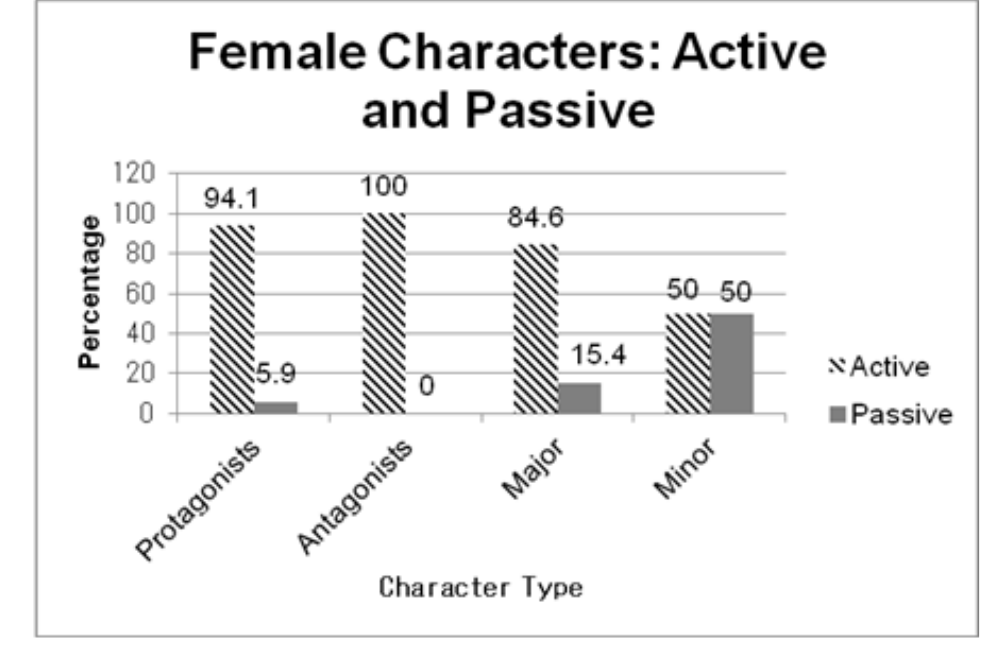
Females divided by overall activeness or passiveness. It is likely that character position and authority has more supremacy in determining a character’s active or passive stance, rather than